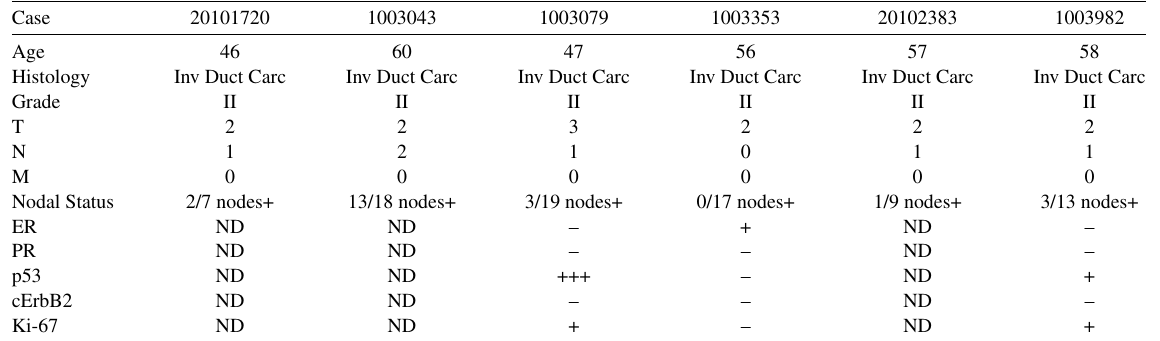
Patients’ breast cancer tumors information. Clinical information is shown for the six patients’ tumor specimens utilized in this study. All specimens were surgically resected from female patients and upon histologic examination were classified as invasive ductal